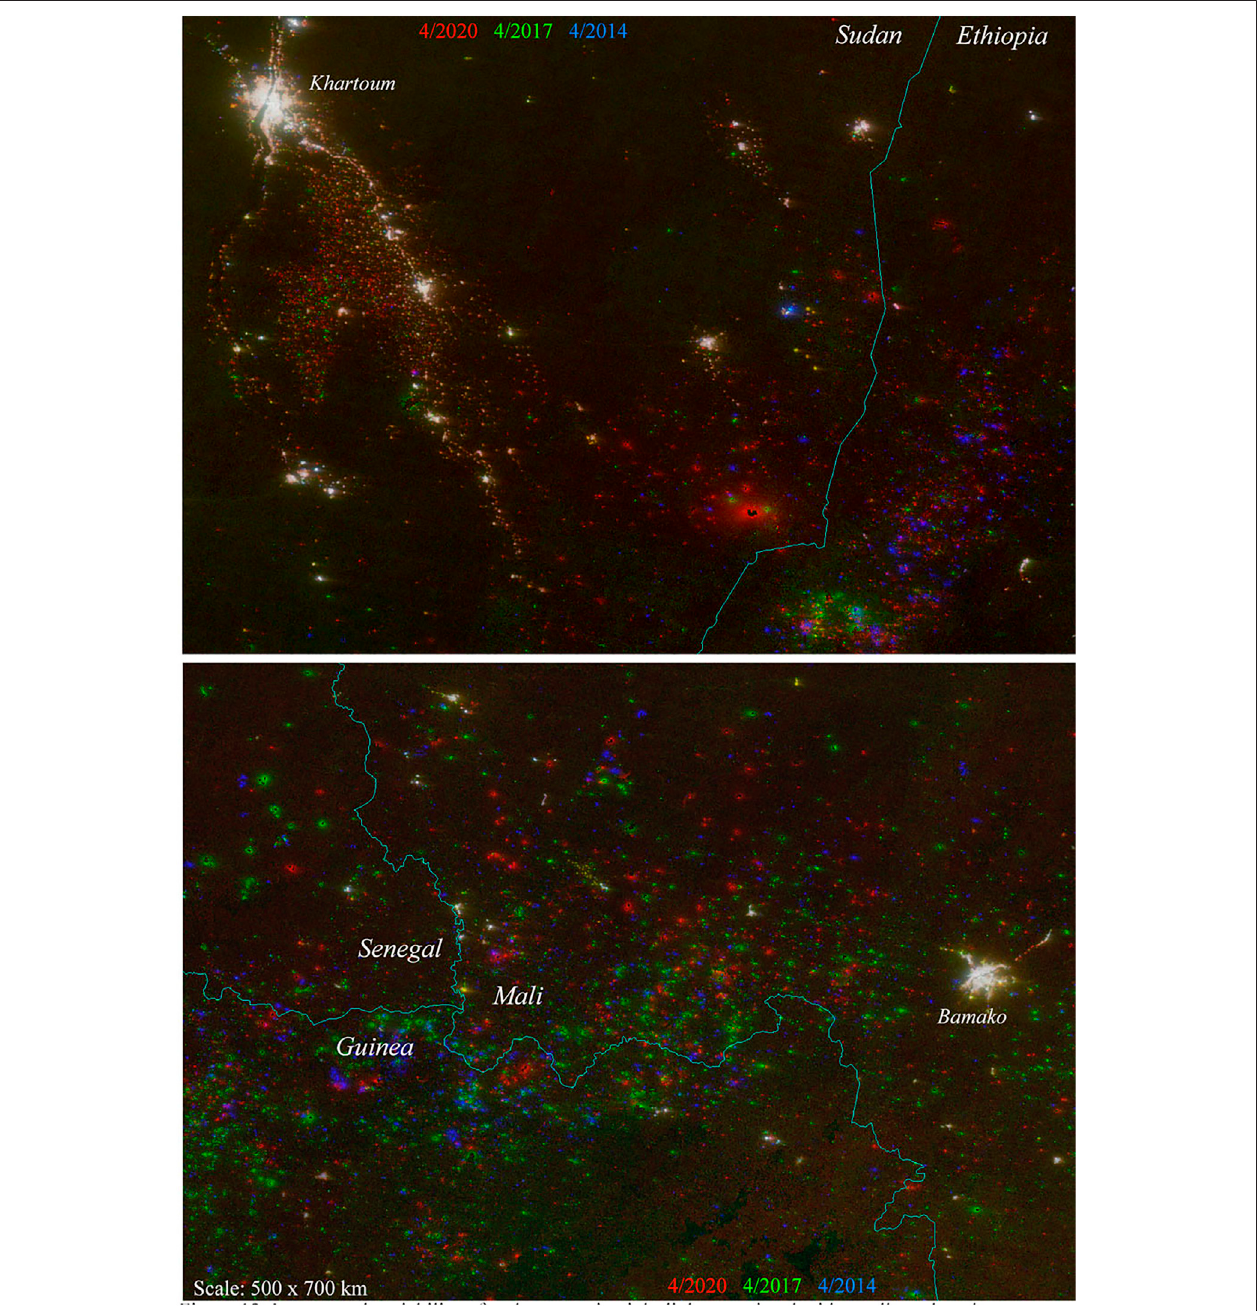
FIGURE 12 | Interannual variability of anthropogenic night light associated with small rural settlements in Africa. Stable lights appear shades of gray. Color implies change. Most small sources southeast of Khartoum (top) show progressive brightness increase since 2014 (red), but those in Ethiopia show both sustained increase and decrease (blue). In contrast, numerous small sources in western Africa (bottom) show both sustained increase and increase followed by decrease (green). In the latter case, the decrease post 2017 is partial with 2020 brightness still greater than in 2014.